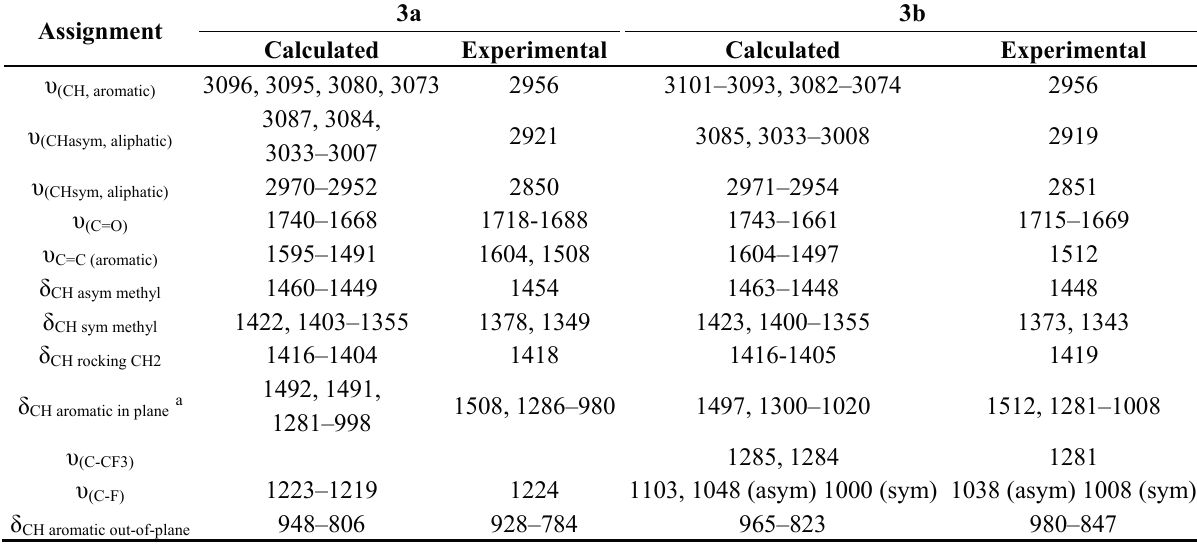
Figure 7. The calculated scaled [44] infrared vibrational spectra of the studied compounds. Table 4. The calculated and experimental wavenumbers of the studied compounds 3a , b